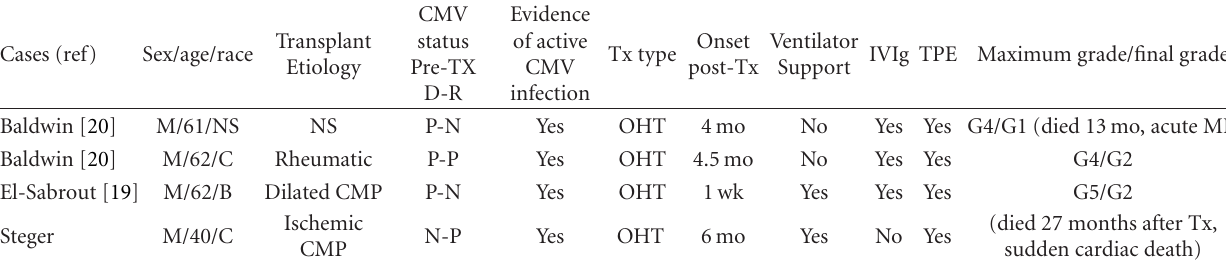
Table 1: Reported cases of cytomegalovirus-associated Guillain-Barr´e syndrome after cardiac transplantation [19].